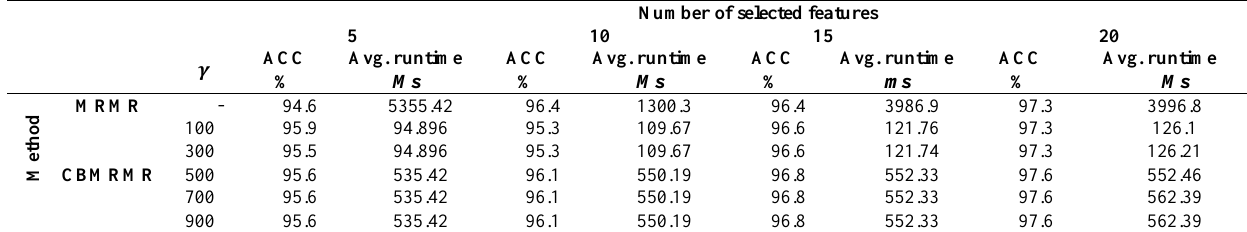
Table 2. Evaluation of suggested anti-phishing system for several values of 